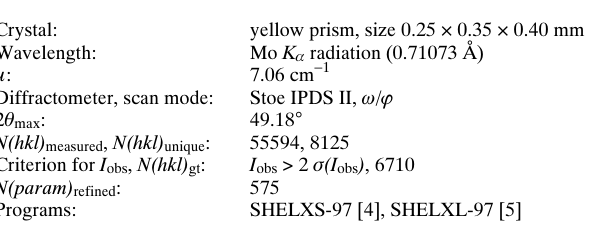
Table 1. Data collection and